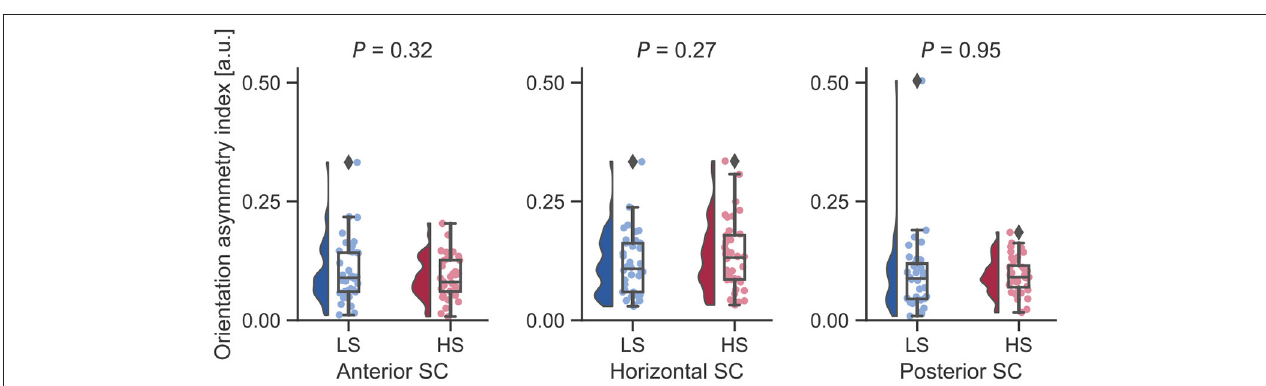
FIGURE 3 | Between-group comparisons of orientation asymmetry index for each bilateral SC pair. There were no significant differences on a two-tailed Welch’s t -test. Diamonds represent outliers.